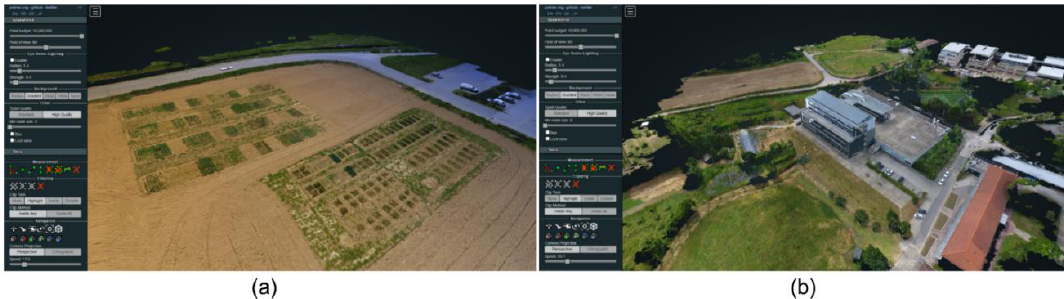
Figure 9. Point cloud visualization, using Potree in first study area ( a ) and second study area ( b ).